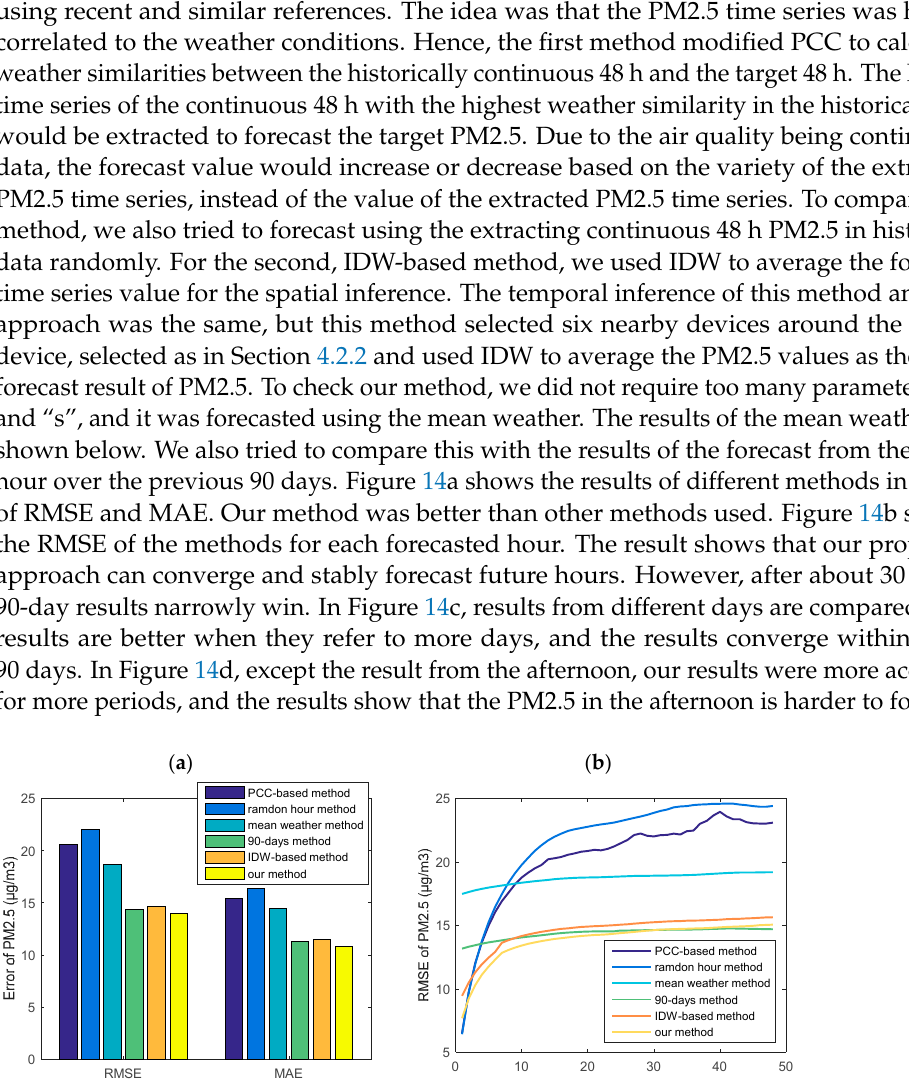
Table 2. Grade of PM2.5 from Environmental Protection Administration Executive Yuan (R.O.C.). Grade Good